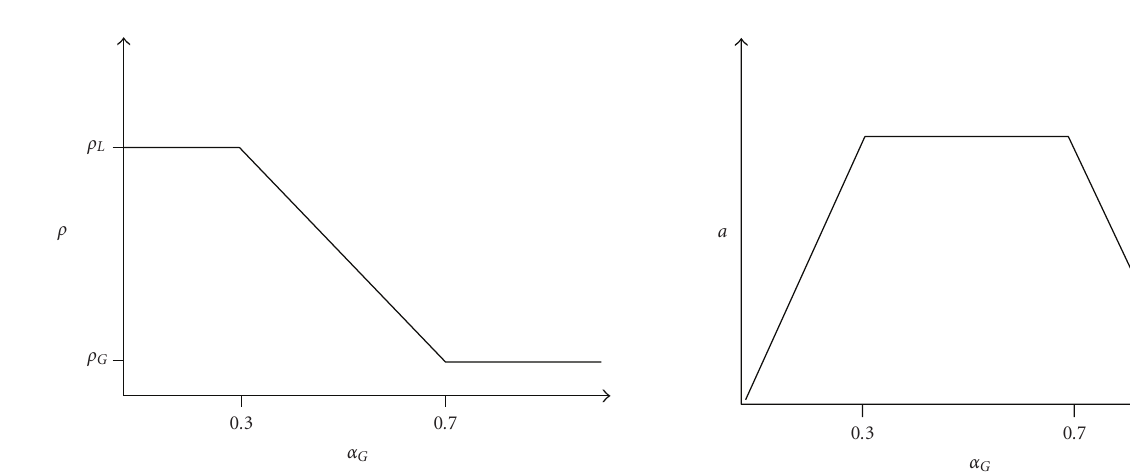
Figure 11: The area density as a function of the gas void